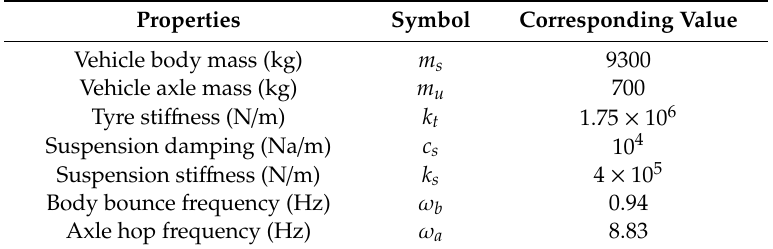
Table 1. Properties of the quarter-car. Reproduced from OBrien et al. Application of empirical mode decomposition to drive-by bridge damage detection. Eur. J. Mech. A Solid 2017; 61, 151–163 . Copyright © 2017 Elsevier Masson SAS. All rights reserved. [25].